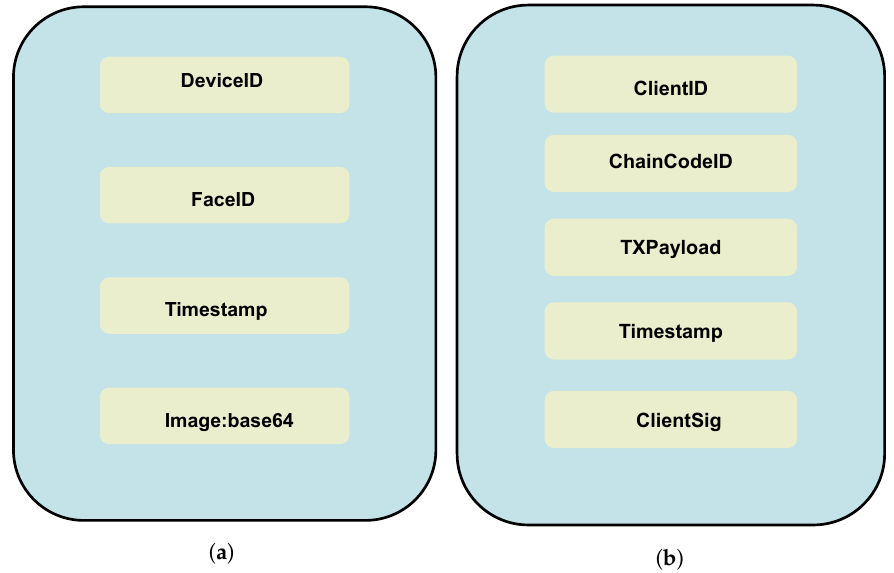
Figure 6. JSON Formats Used: ( a ) Sent From Esp Eye Devices, ( b ) Included in the HLF TX